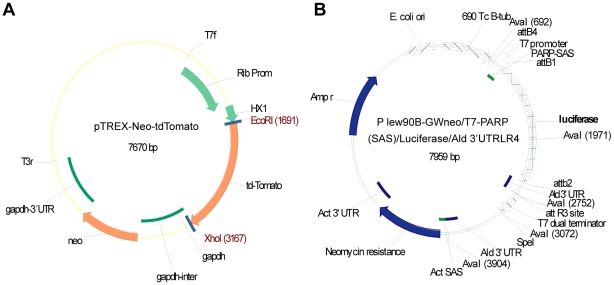
Plasmids used in the generation of fluorescent and bioluminescent T. cruzi.Schematic representation of (A) the pTrex-Neo-tdTomato plasmid, and (B) the pLew90β-GW/T7/PARP SAS/luciferase/Aldolase 3′UTR plasmid used for generation of the T. cruzi reporter lines.